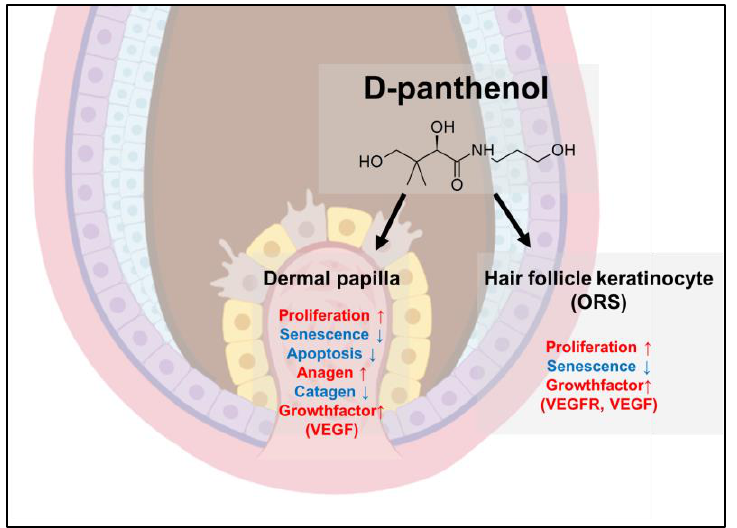
Figure 8. Summarized in vitro effects of D-panthenol in hair follicle cells. All these effects in combination could lead to hair growth promotion. ↑ :upregulation, ↓